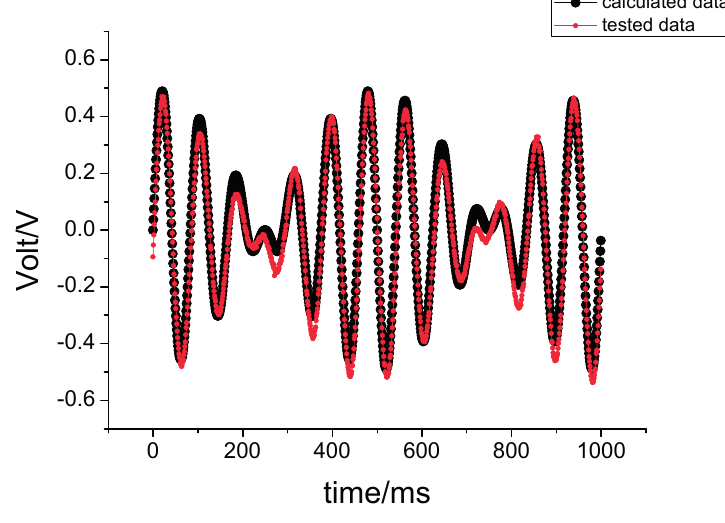
Figure 11. The experimental results under input angular